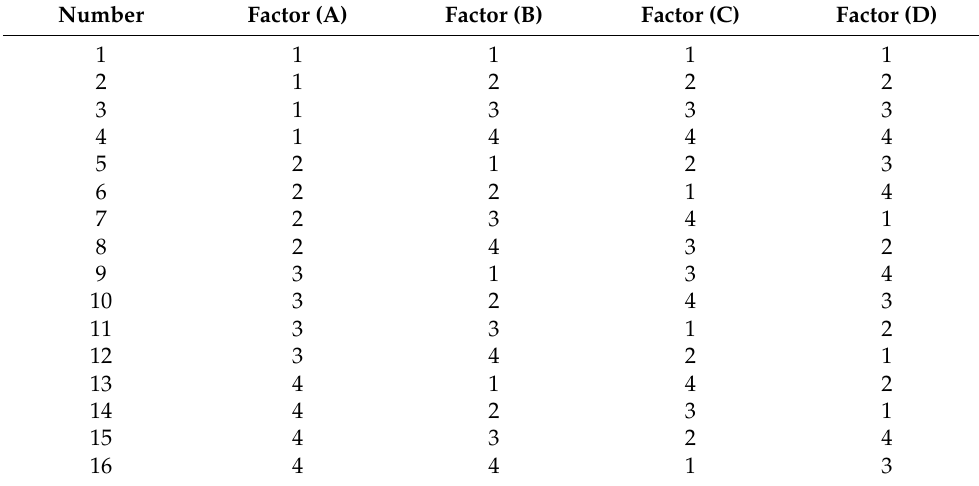
Table 3. The Taguchi L 16 orthogonal